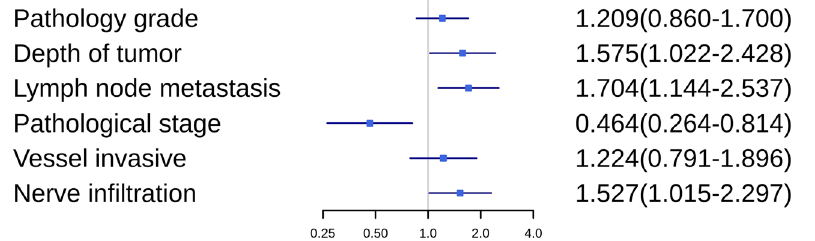
Figure 2. Forest map showing logistic regression analysis of PDW and its predictive value for adverse pathological outcomes.